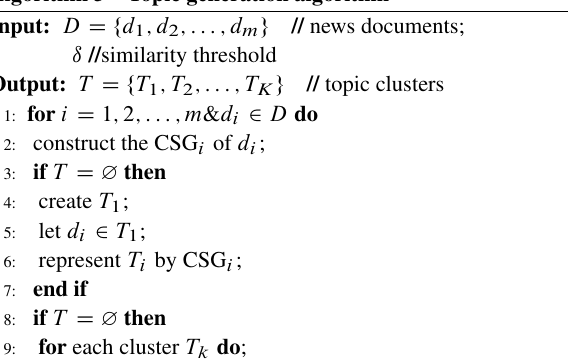
Algorithm 3 Topic generation